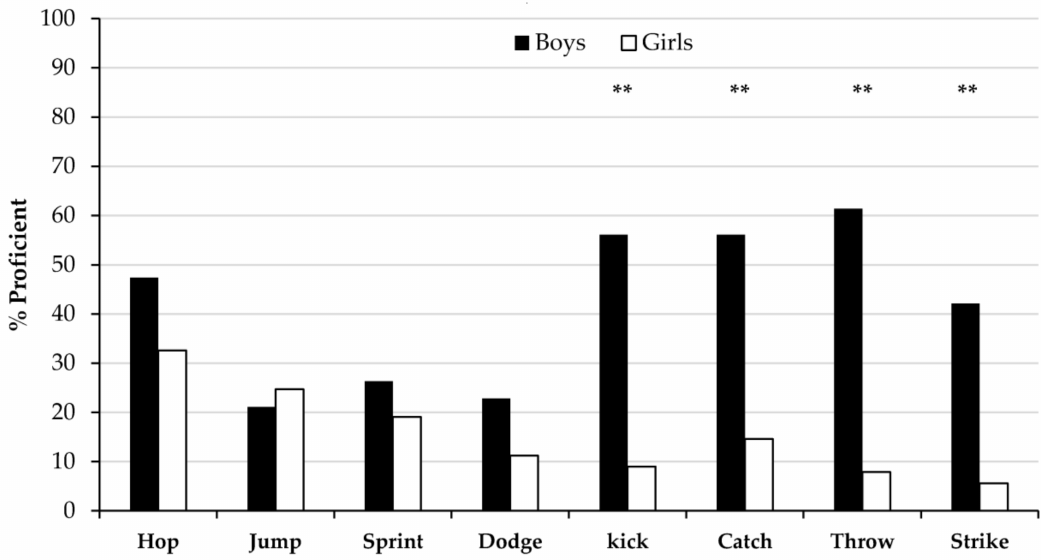
Figure 3. Prevalence of proficiency at fundamental movement skills (** p <